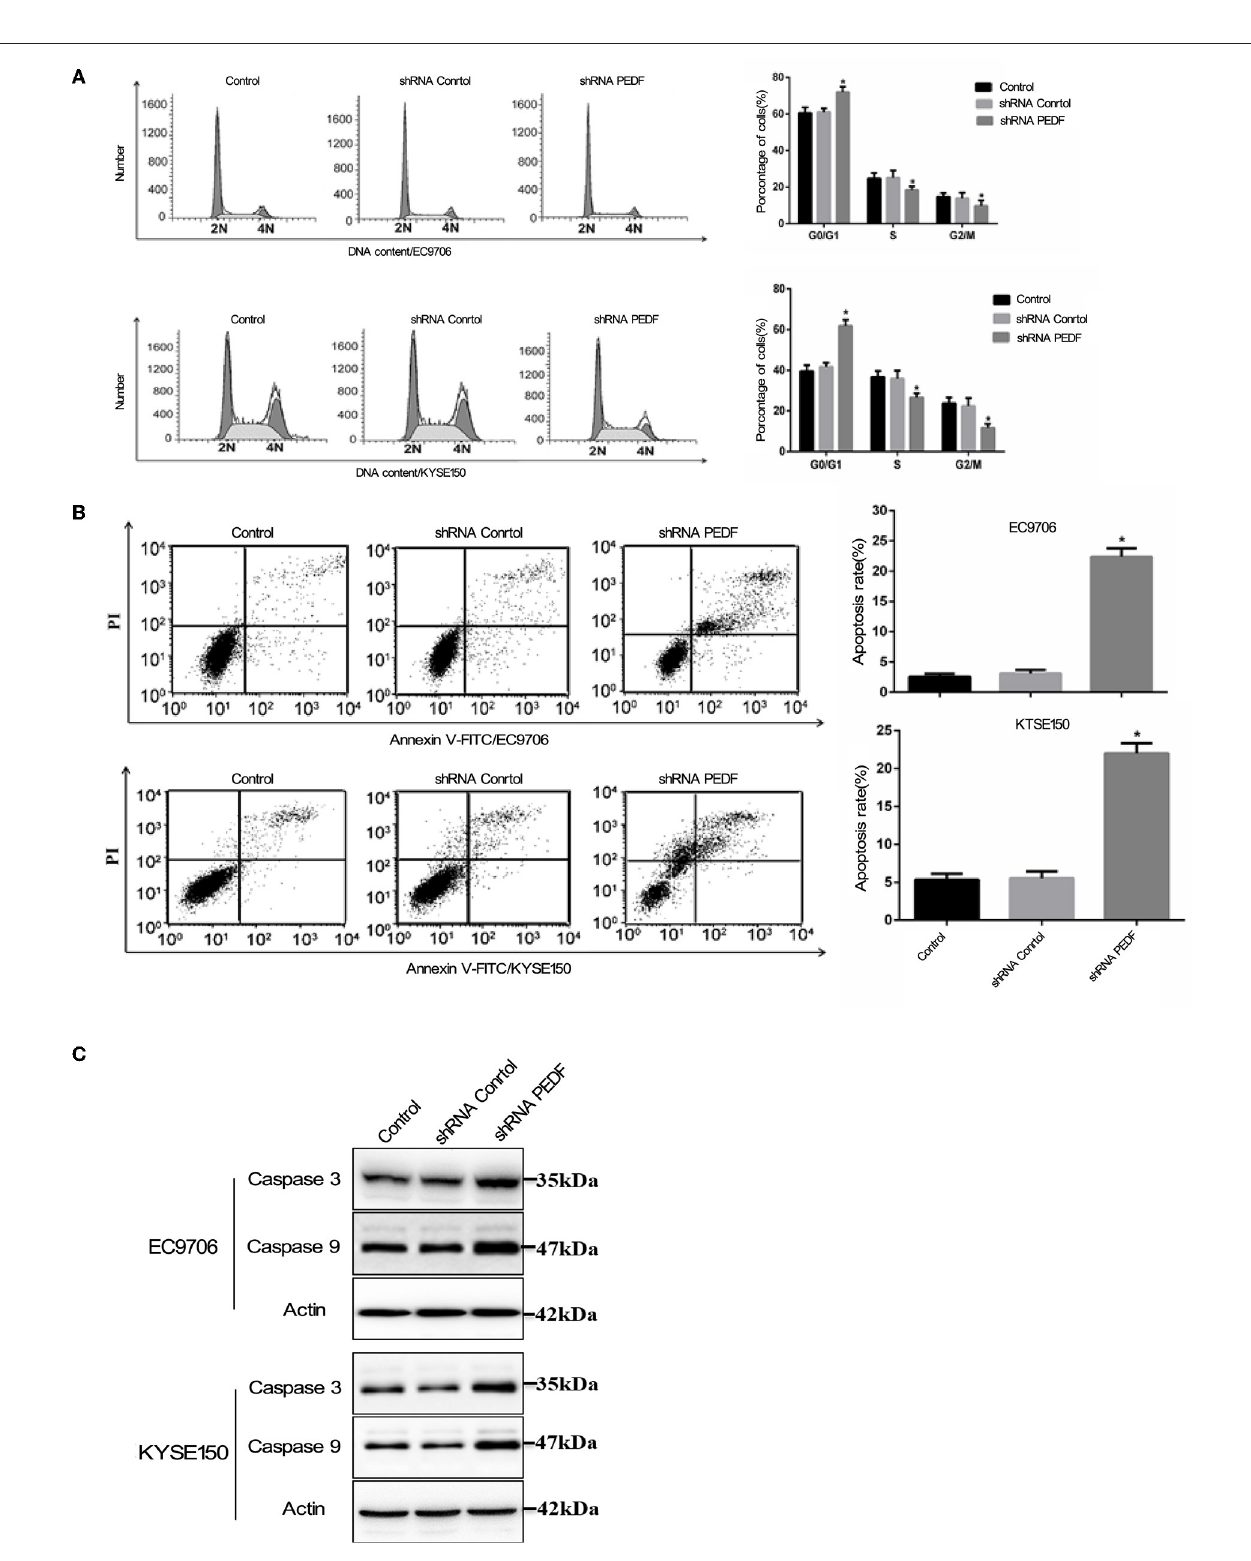
FIGURE 4 | Xenografts with or without PEDF knock down in nude mice. (A) Tumor size at the end time point. (B) Tumor volume over all time points. (C) Tumor weight at the end time point. * < 0.05.